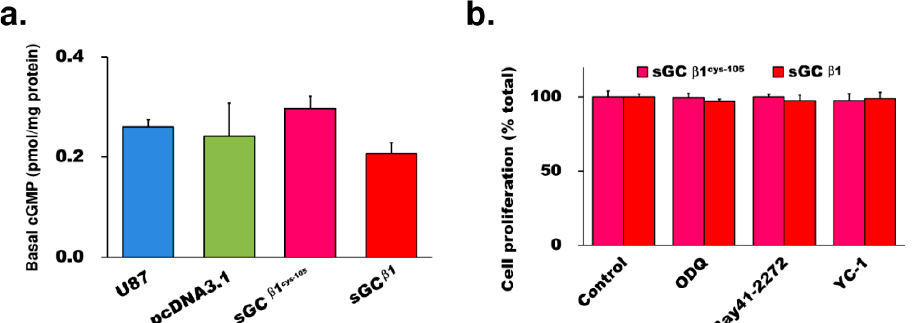
Figure 2. Assay of cGMP levels and the effects of sGC activators or inhibitors on sGC β 1- overexpressing cells. ( a ) cGMP levels were not significantly changed in U87 and pCDNA3.1-, sGC β 1 Cys105 -, and sGC β 1-transfected cells. ( b ) Proliferation assay of the cells with overexpression of sGC β 1 Cys105 and sGC β 1 treated with ODQ (10 µM), Bay41-2272 (1 µM), or YC-1 (10 µM). Cell numbers were normalized to the numbers of untreated cells. There were no significant differences between the groups ( p >